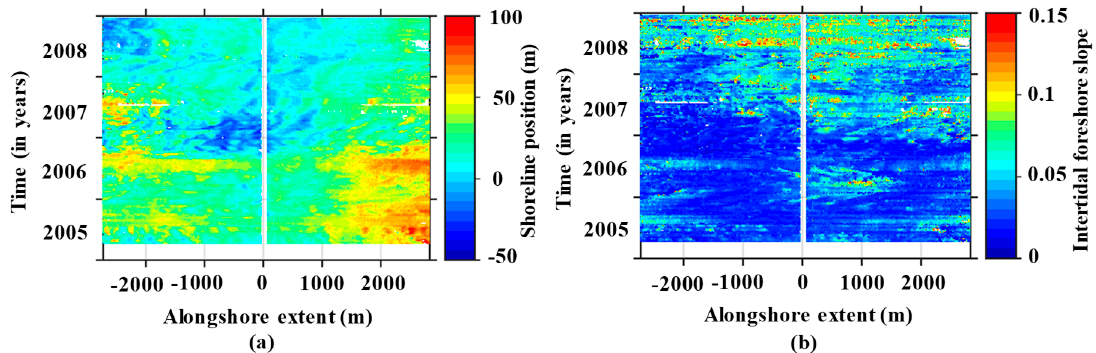
Figure 13. Spatial and temporal variations in ( a ) the shoreline positions and ( b ) the intertidal foreshore slopes estimated by mTWM during 12 April 2005 to 31 December 2008.